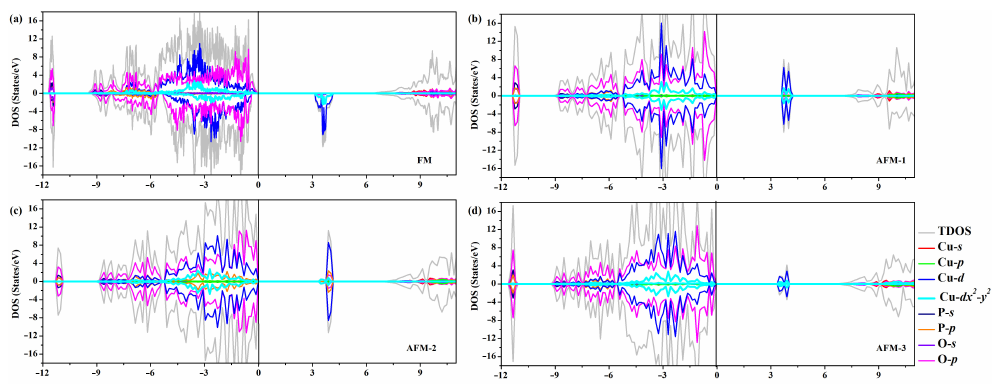
Figure 3. ( a – d ) Electronic total density of states (TDOS) and atom-projected density of states for α -Cu 2 P 2 O 7 in the four studied states of magnetic order, as calculated within HSE density functional. The zero of energy is chosen at the highest occupied level at 0